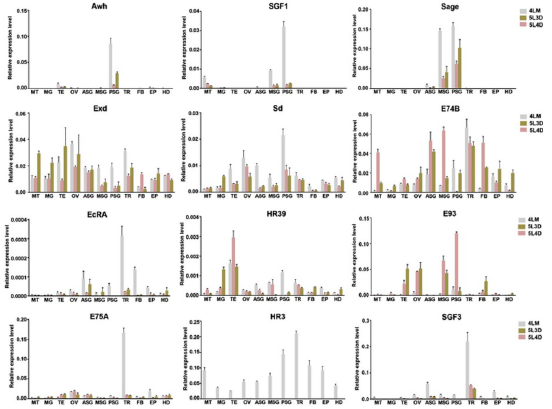
Fig 7. Expression of 12 TFs in different tissues and developmental stages. The expression levels of 12 TFs in different tissues and developmental stages of B . mori larvae were quantified by qRT-PCR. Relative mRNA levels are calculated as the ratio of target TF mRNA level to BmeIF4A mRNA level. Error bars represent the mean ± SD of three samples. MT, Malpighian tubule; MG, midgut; TE, testis; OV, ovary; ASG, anteriorsilkgland; MSG, middle silk gland; PSG, posterior silk gland; TR, trachea; FB, fat body; EP, epidermis; HD, head. 4LM, the fourth molt; 5L3D, day-3 fifth instar; 5L4D, day-4 fifth instar.